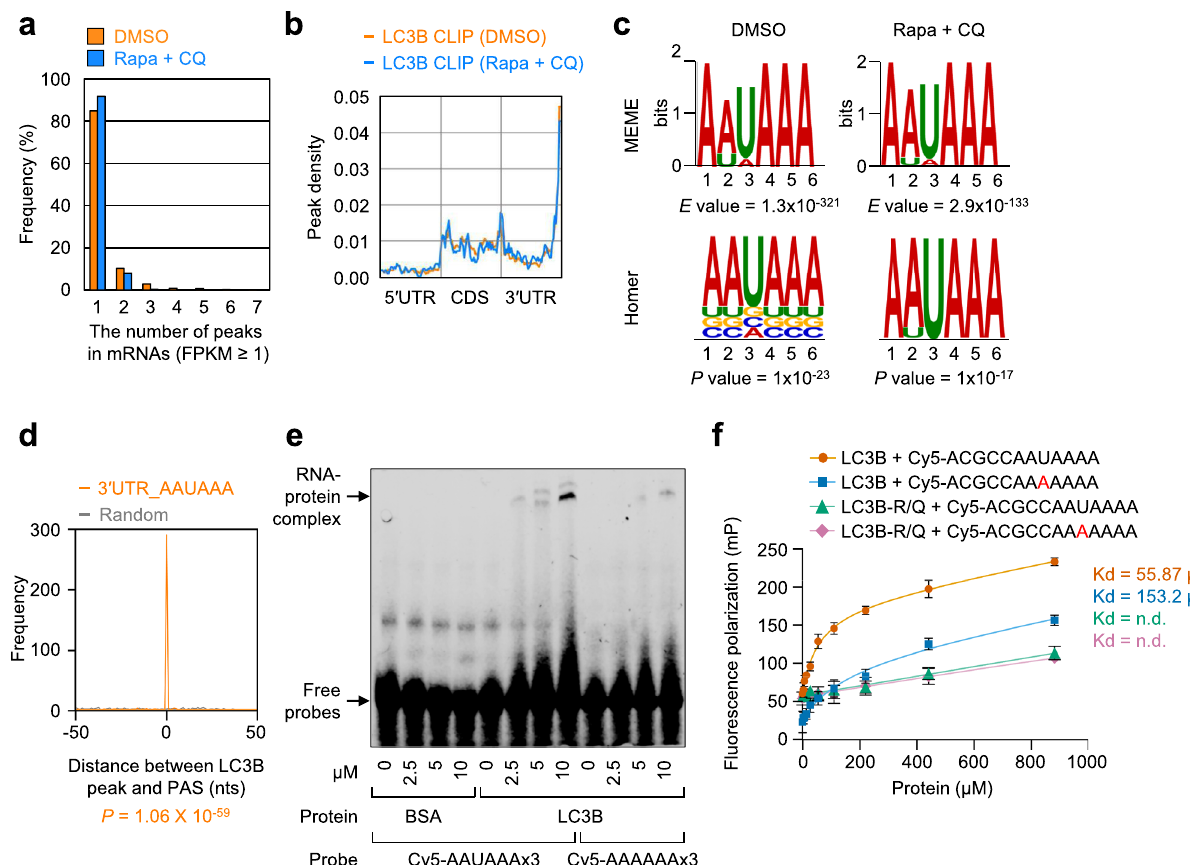
Fig. 1 LC3B is an RNA-binding protein with a preference for AAUAAA consensus motif. a – d CLIP-seq of endogenous LC3B on HEK293T cells treated with either DMSO or Rapa + CQ. Data obtained from two biological replicates of LC3B CLIP-seq were analyzed. The mRNAs with FPKM ≥ 1 in the DMSO- treated cells were used for the calculations. a The number of LC3B CLIP peaks in mRNAs. b Metagene pro fi les of LC3B peaks. Each region of the 5 ′ UTR, CDS, or 3 ′ UTR was binned into 50 segments. c Consensus motif for LC3B binding. The consensus RNA sequences from LC3B peaks located in the 3 ′ UTR in the cells treated with either DMSO (left) or Rapa + CQ (right) were predicted by MEME (upper) or HOMER (lower). The E value (upper) estimates the expected number of motifs with a similarly sized set of random sequences using log likelihood ratio. The p values (lower) were calculated using cumulative binomial distributions. d Pro fi les of the distance between LC3B peaks located at the consensus AAUAAA motif and polyadenylation signal (PAS). p values were calculated using the two-tailed Kolmogorov – Smirnov test. e EMSA analysis using in vitro-synthesized Cy5-labeled triple repeats (×3) of either AAUAAA or AAAAAA and either puri fi ed recombinant LC3B-WT or BSA. The relative positions of the free probes and RNA-protein complexes are indicated using arrows. Representative data obtained from two independently performed biological replicates ( n = 2) are shown. f Fluorescence polarization assay showing preferential interaction between puri fi ed recombinant LC3B and AAUAAA motif. Dissociation constants (Kd) are indicated at the right side of graph; n = 6; Data are presented as mean values ± SD; nd not determined. Source data are provided as a Source Data fi